Question: What visual encoding does this figure use to show its data?
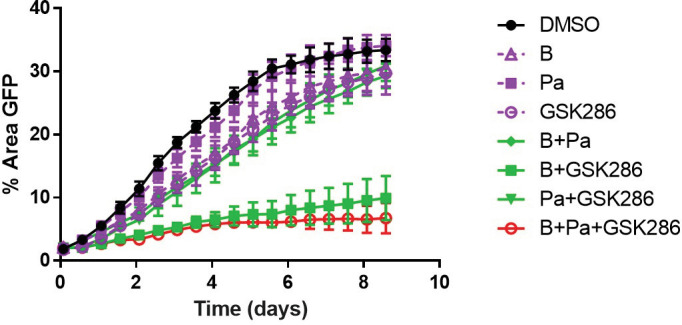
Answer: line